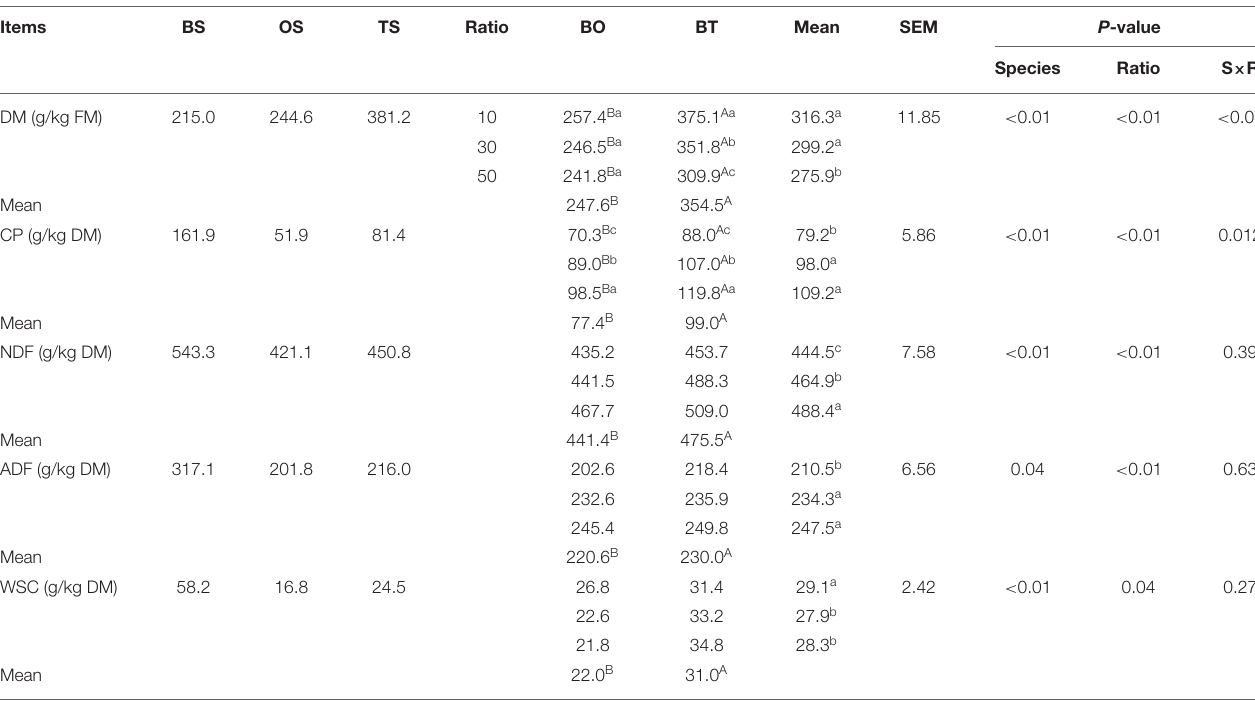
TABLE 2 | Chemical composition after ensiling.